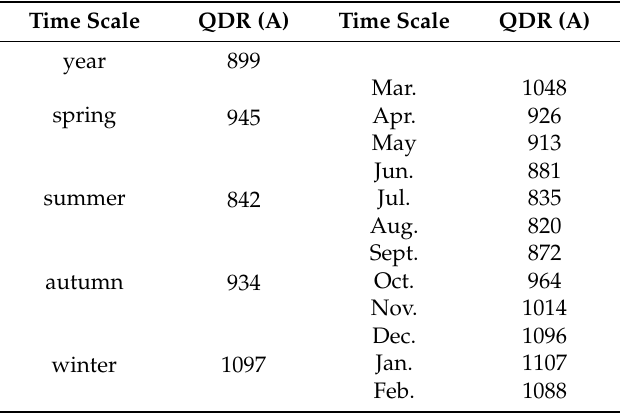
Table 3. Yearly and seasonally ratings under different confidence